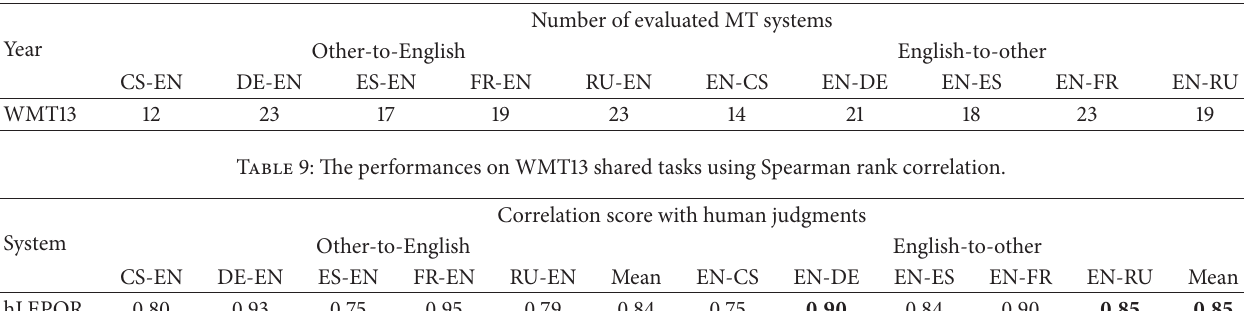
Table 8: The number of effective MT systems in WMT13.